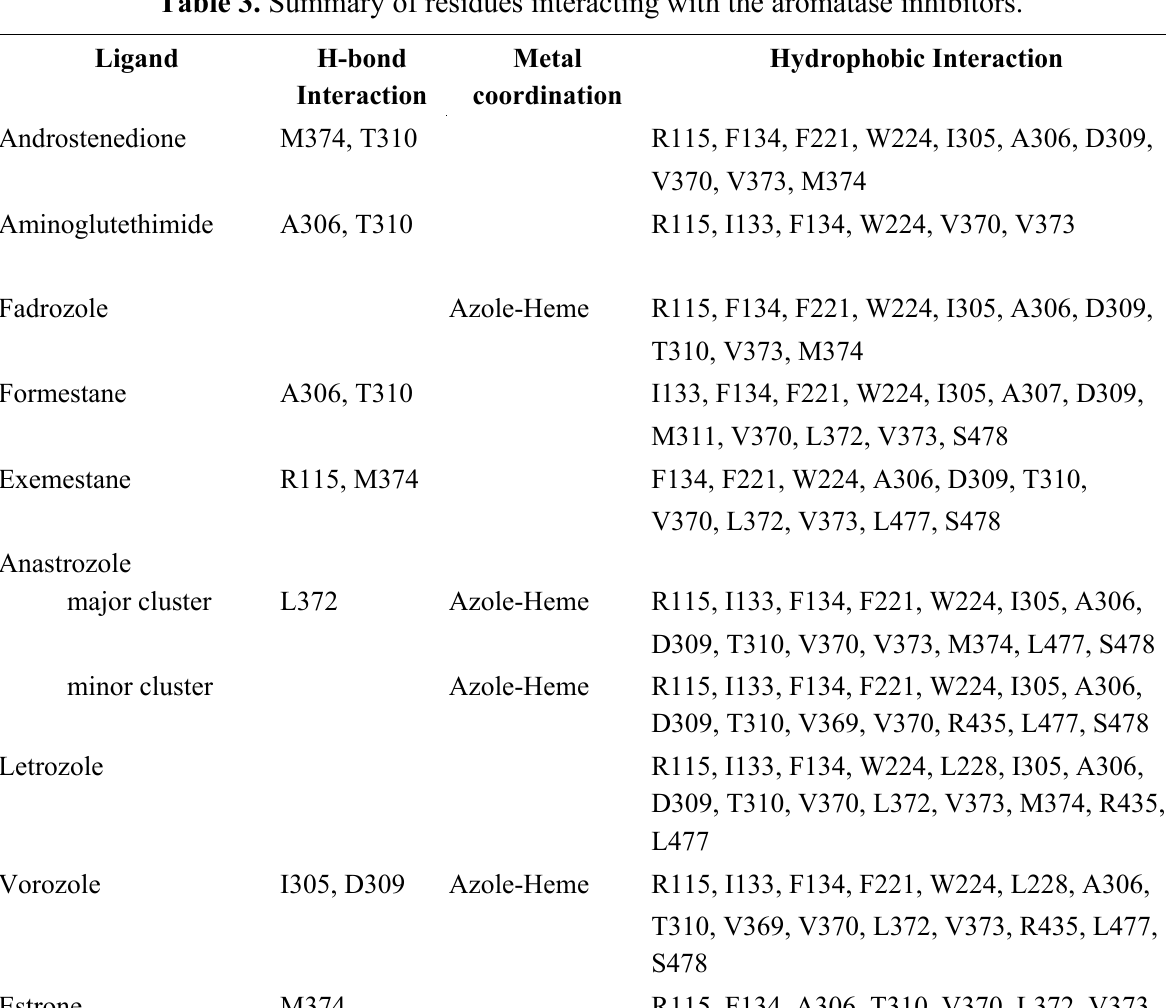
Table 3. Summary of residues interacting with the aromatase